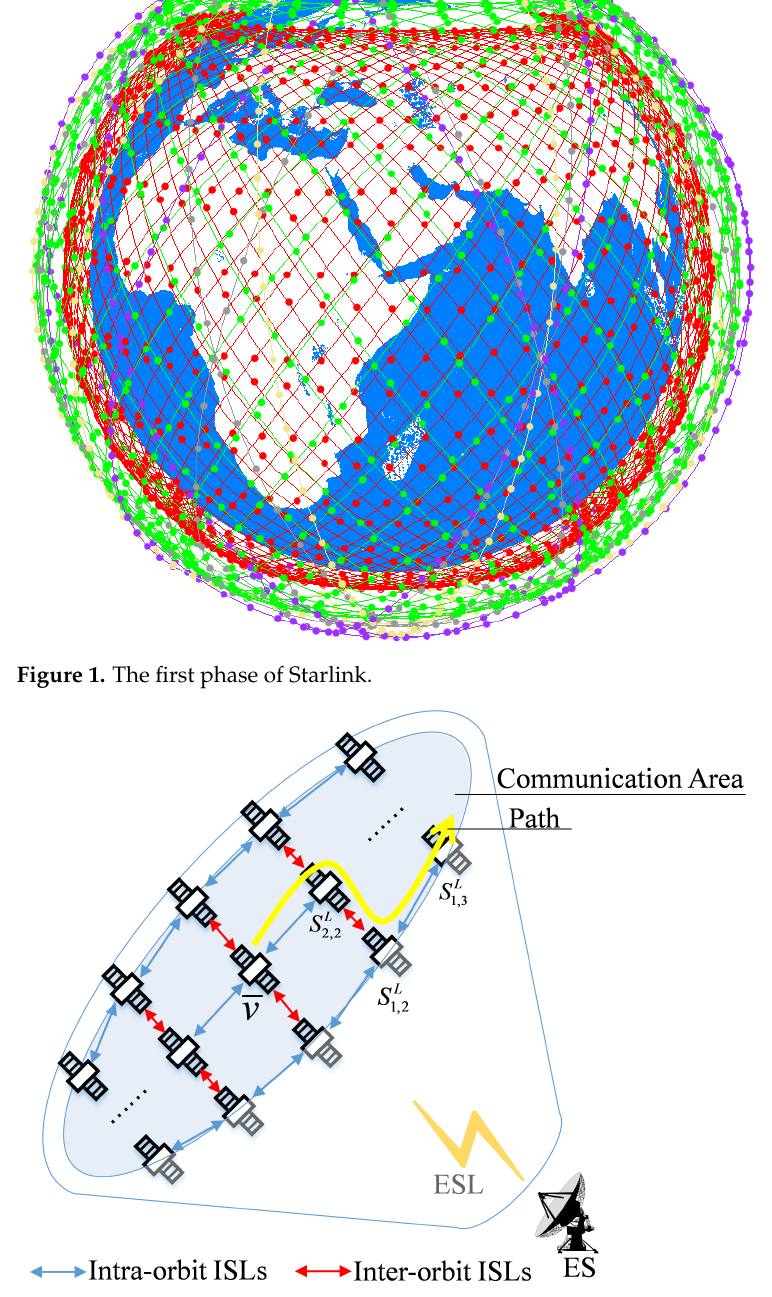
Figure 2. Communication domain of the